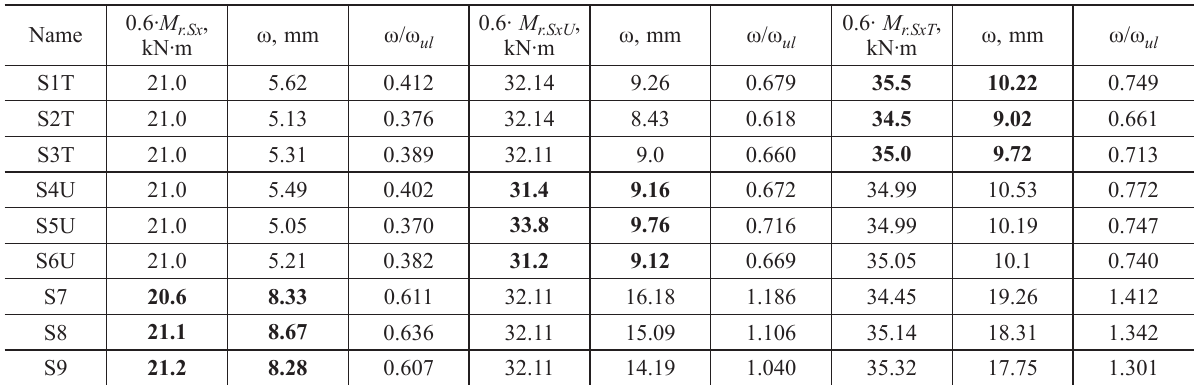
Table 14. Deflection of the beams when M = 0.6· M r